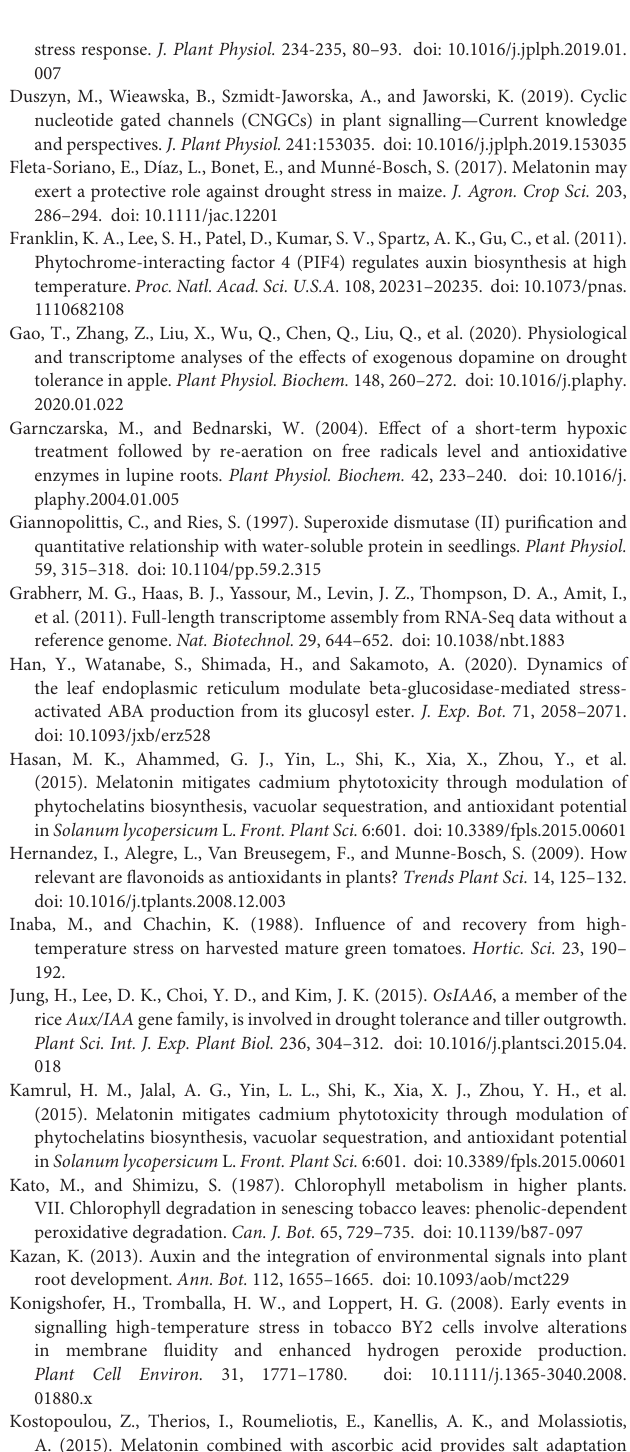
Supplementary Table 11 | Detailed information of the changes in the expression of starch and sucrose in Con, ConMT, S, and SMT comparisons. Supplementary Table 12 | Detailed information of the changes in the expression of the vital genes in the Ca 2 + signal transduction, starch and sugars metabolism in Con, ConMT, S, and SMT comparisons.